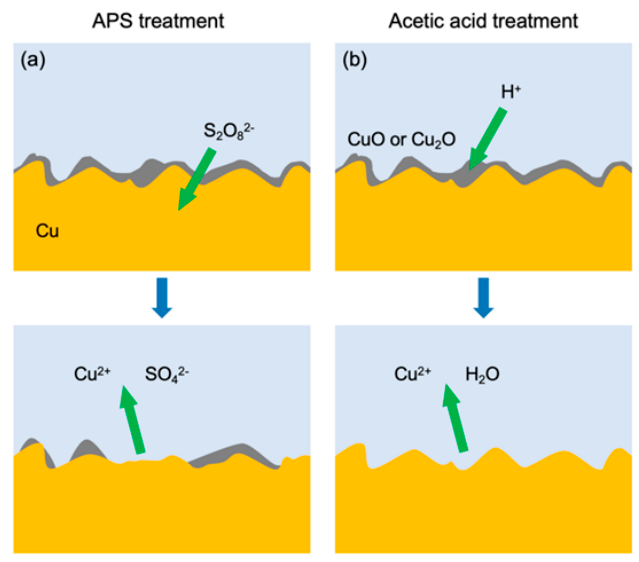
Figure 3. Surface etching process of copper foils by ( a ) AP; ( b ) AA.